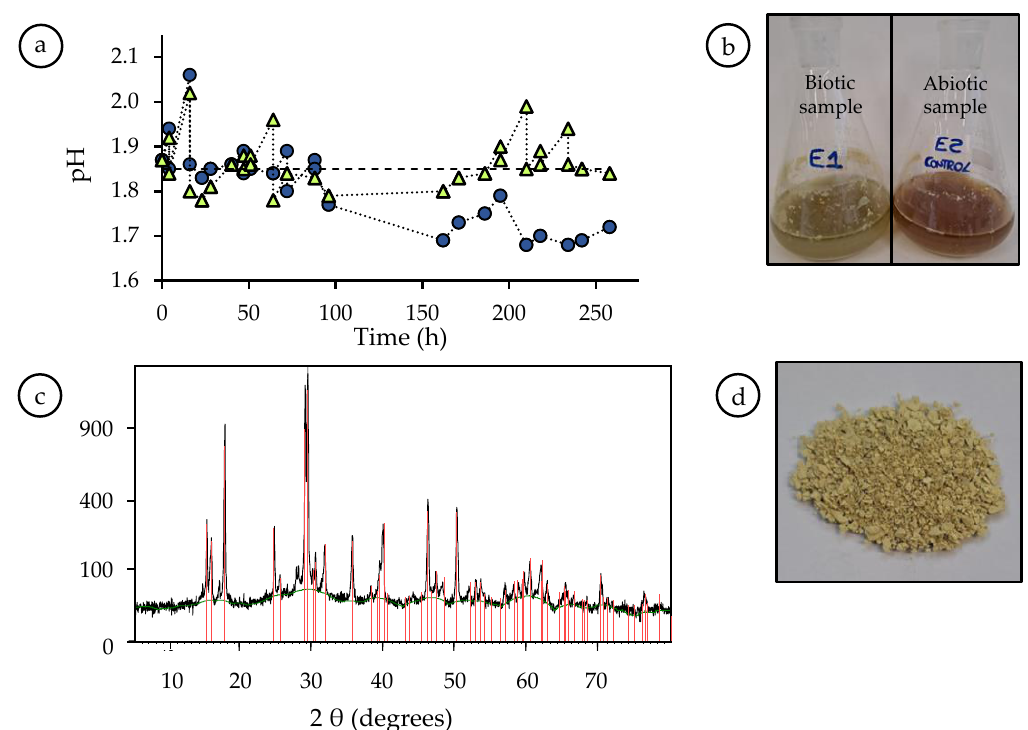
Figure 6. ( a ) pH evolution during the two-step leaching experiment in biotic (blue square) and abiotic (green circle) 9 K medium and ( b ) appearance of the leaching solutions when using Fe 3+ as oxidant after 260 h. ( c ) XRD patterns for ( d ) solid precipitated at the end of the experiments (black line) and rhombohedral KFe 3+ 3 (SO 4 ) 2 (OH) 6 jarosite (PDF: 36–427) (red line). The mustard-colored solid precipitated in the Erlenmeyer flasks (Figure 6b) was identified by XRD as a compound related to the jarosite-group minerals with the chemical